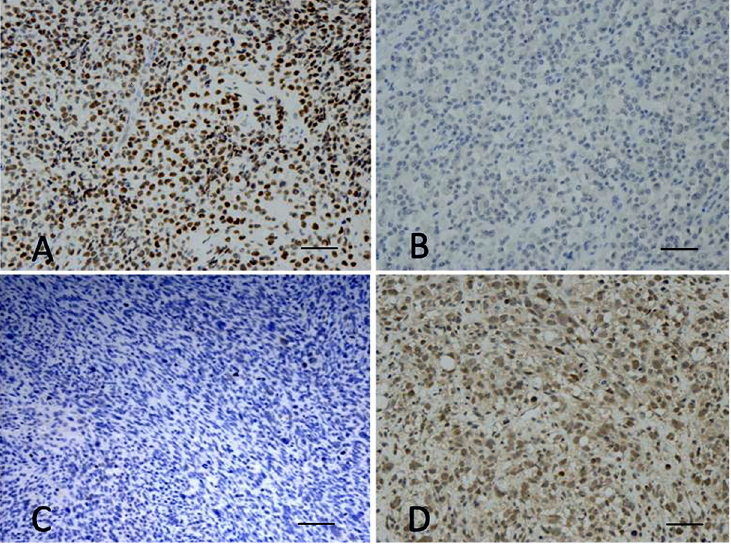
Fig 3. (A) Positive immunostaining for DAX-1 in histological section of a t+ ARMS. (B,C) Negative immunostaining for DAX-1 in histological sections of two different ERMS. (D) Immunostaining for DAX-1 in histological section of a ERMS with the typically weak staining found in non-ARMS (80x, scale bars 240 μ